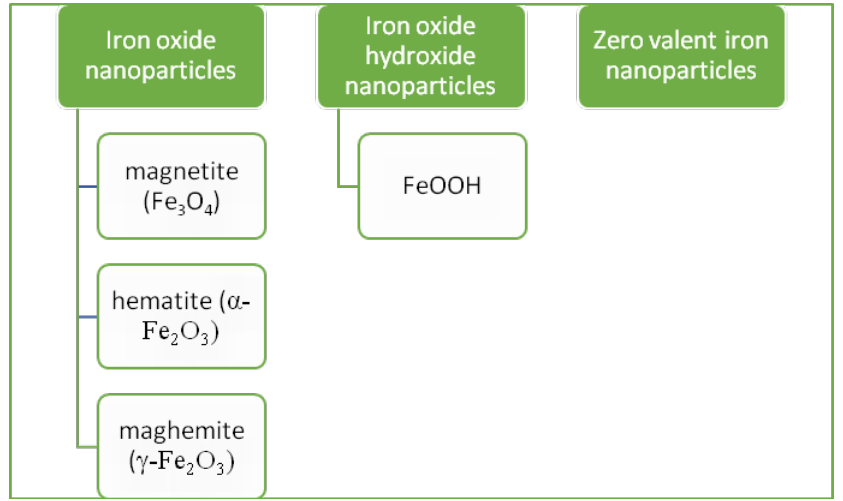
Figure 1. Classification of iron nanoparticles.